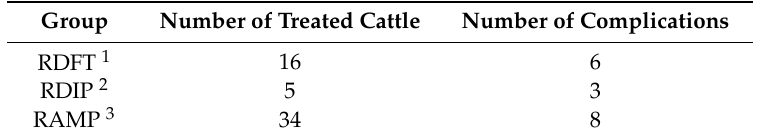
Table 2. Number of treated cattle and number of cattle with postoperative complications in the three treatment